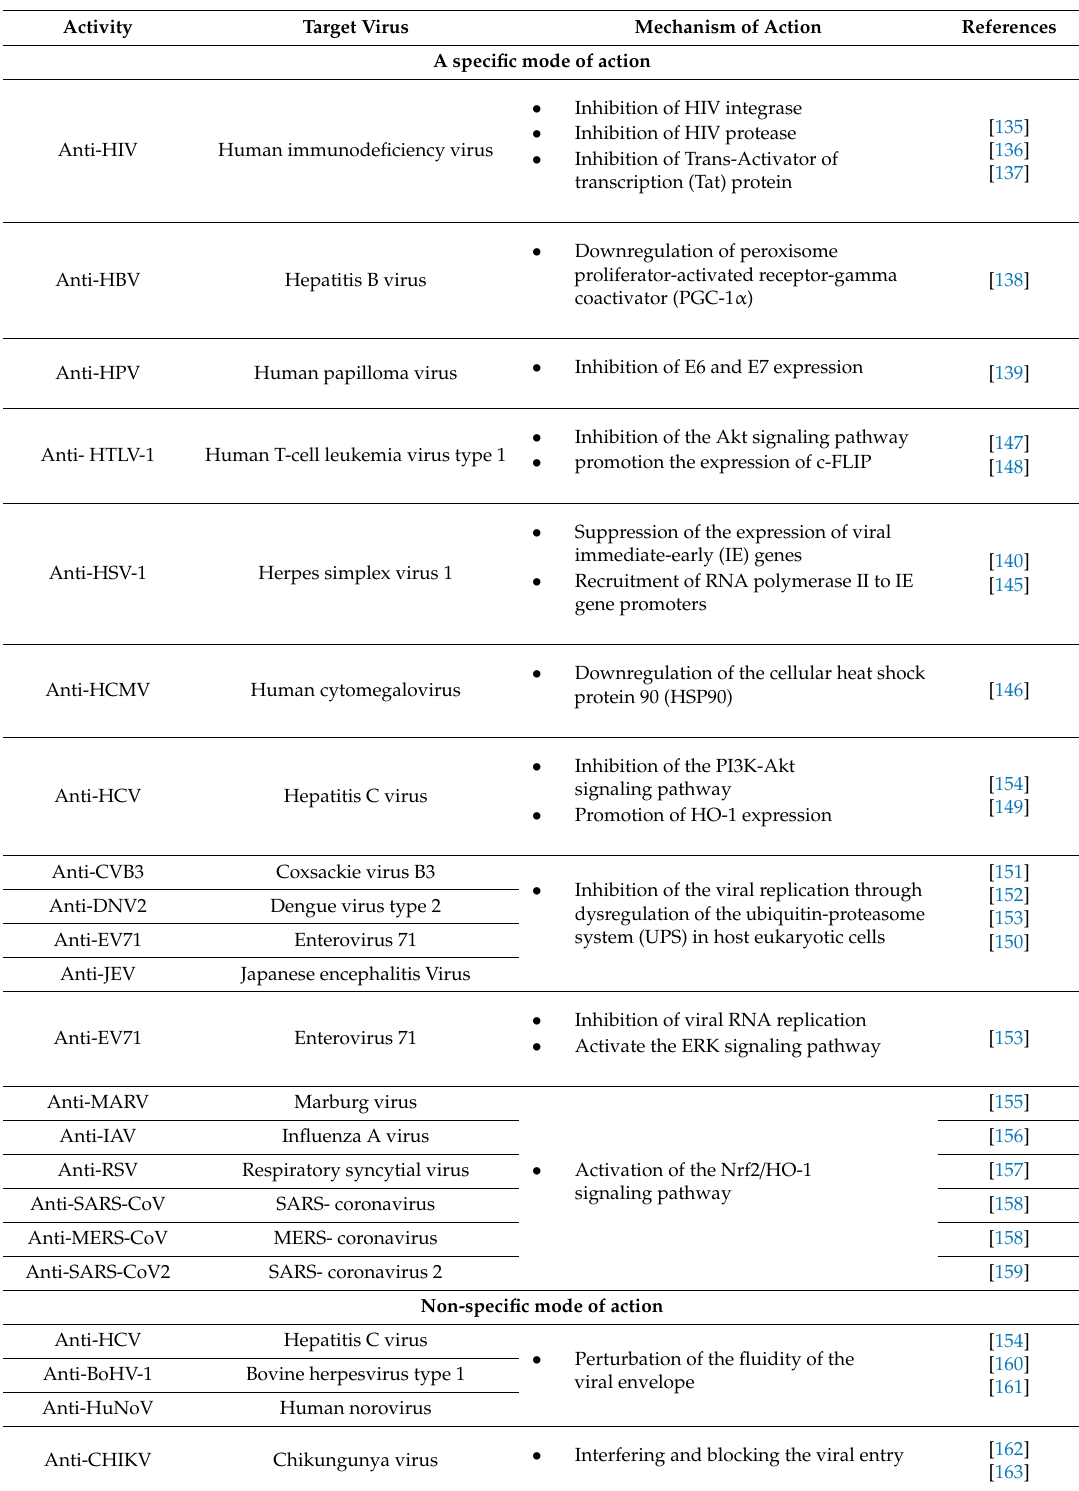
Table 1. A specific and non-specific mode of curcumin potential properties for anti-viral